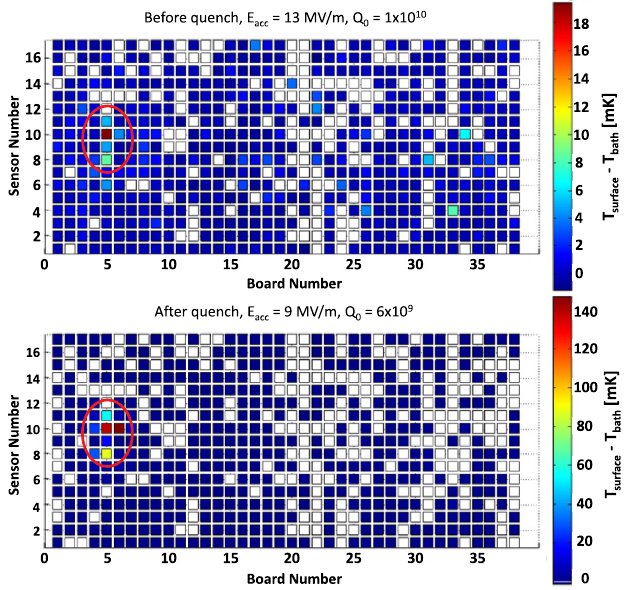
FIG. 8. Temperature maps of cavity B before quench, close to the quench field (top) and after the first quench (bottom). Broken resistors are given a white color. The region of strong localized heating is circled. Note the difference in scale between the top and bottom.